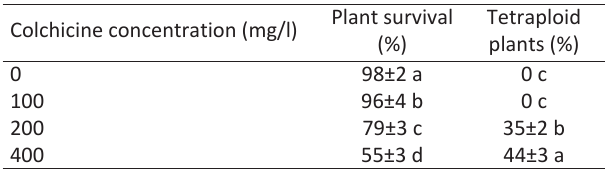
Fig. 3 - Flow cytometry analysis of C. roseus ‘Alba’ cell nuclei in tetraploid (peak 1) and index plant of parsley in diploid status (peak 2).